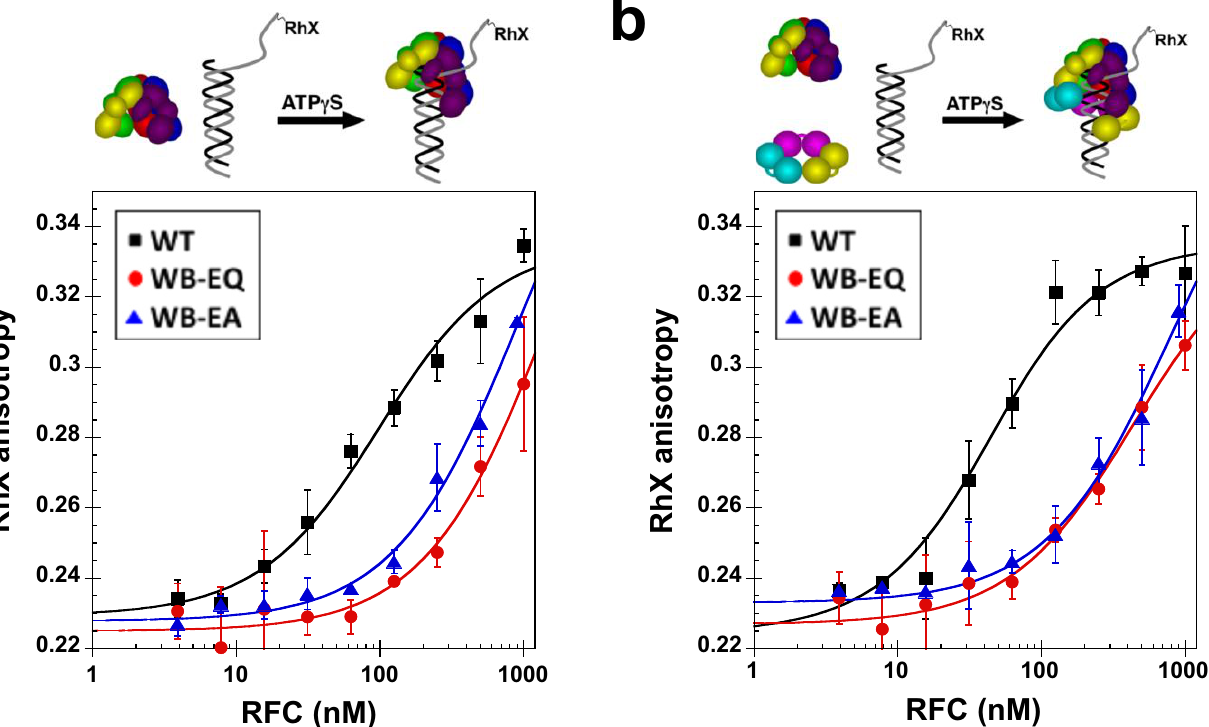
Figure 5. DNA binding activities of WT RFC and Walker B mutants. The anisotropy of RhX covalently attached to p/t DNA was measured as a function of RFC concentration. Binding of WT RFC (squares), the WB-EQ mutant (circles) and the WB-EA mutant (triangles) to DNA was measured in the presence of 0.5 mM ATP (cid:534) S and 20 nM p/t DNA-RhX. ( a ) DNA binding was measured in the absence of PCNA. ( b ) DNA binding was measured in the presence of 2 µM PCNA. Three independent experiments were done and error bars represent the standard